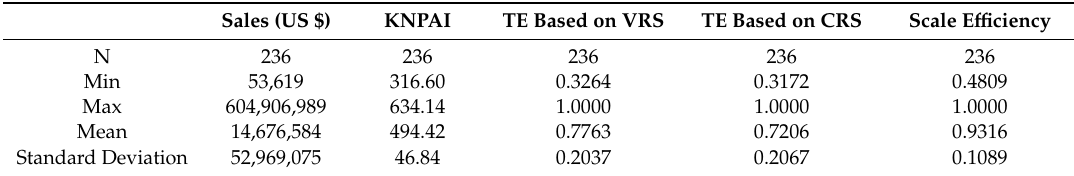
Table 3. Summary of the KNPAI and technical e ffi